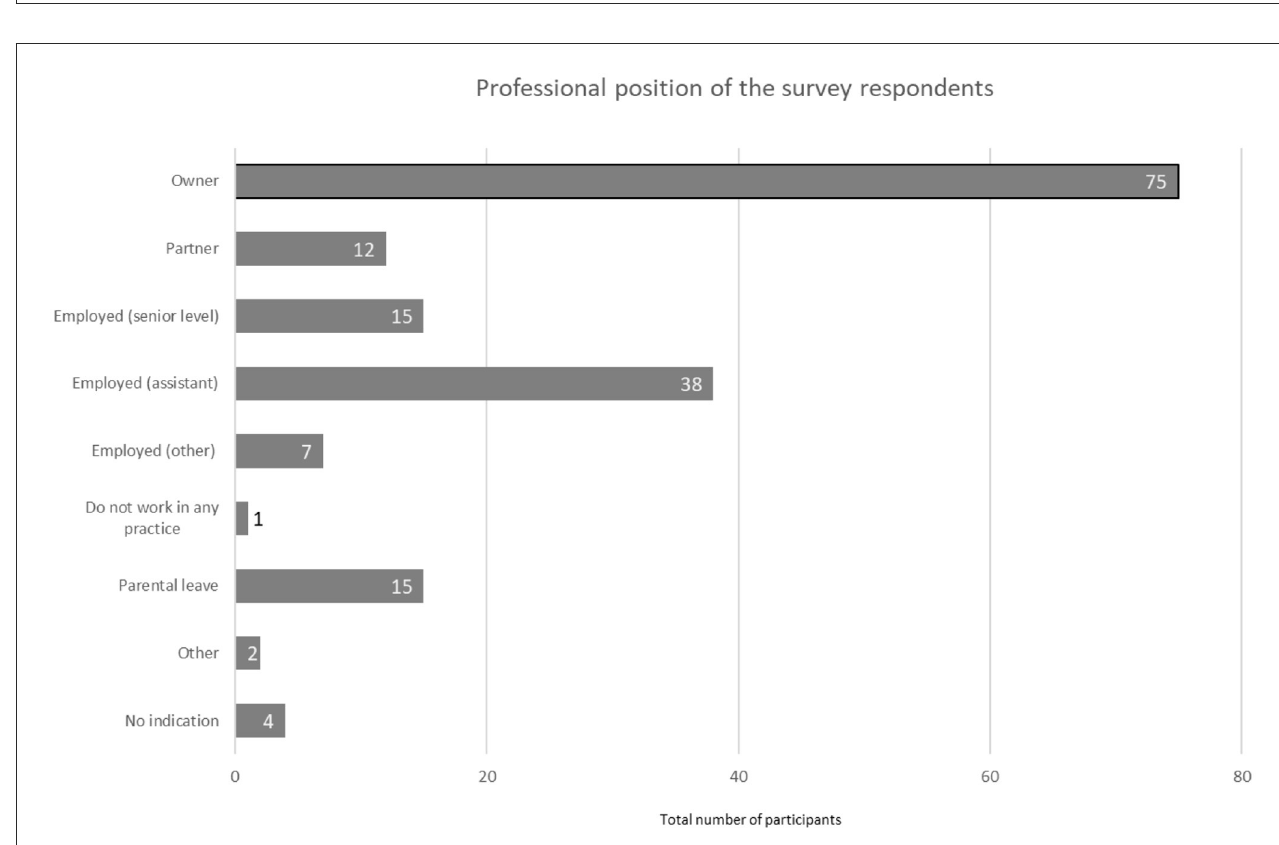
FIGURE4 Professional position of the survey respondents ( N =